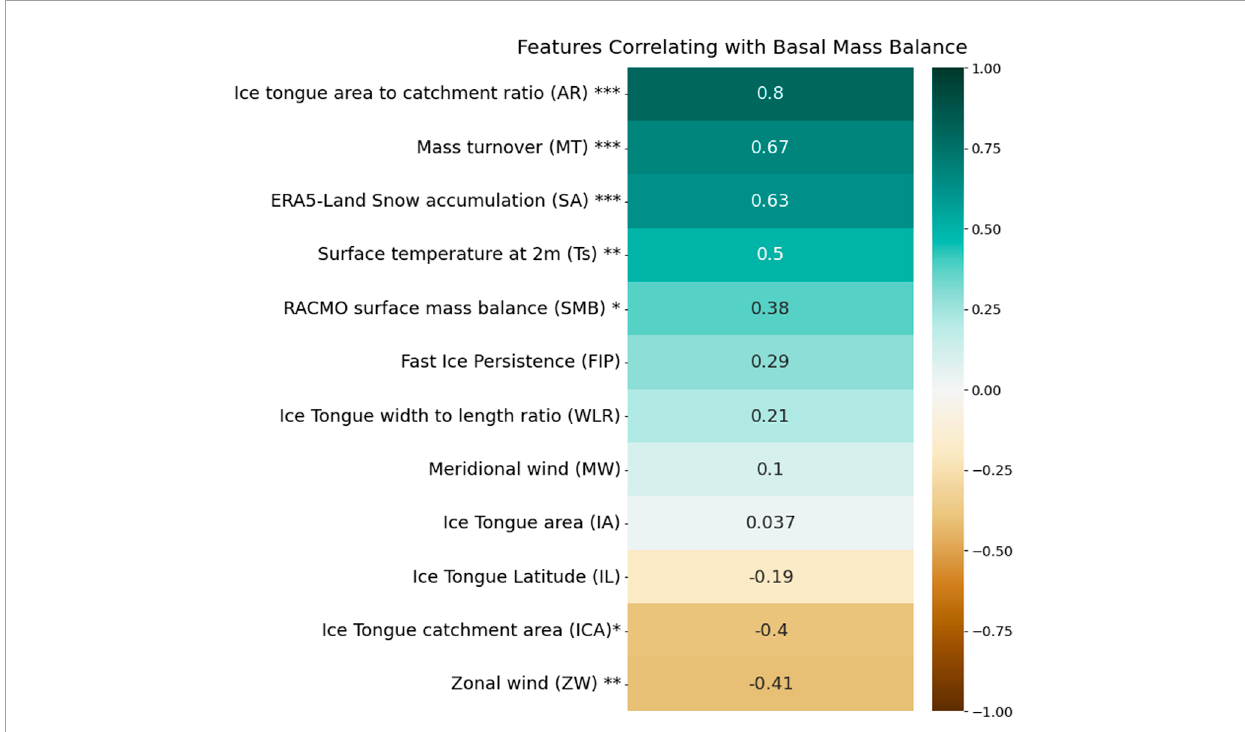
FIGURE 7 Correlation coefficients of different environmental and geomorphological variables with ice tongues basal mass balance. The variables are snow accumulation (SA), surface temperature (Ts), ice tongue mass turnover (MT), ice tongue to catchment area ratio (AR), surface mass balance (SMB), fast ice persistence (FIP), ice tongue width to length ratio (WLR), meridional wind (MW), ice tongue latitude (IL), ice tongue area (IA), ice tongue basin area (ICA), and zonal wind (ZW). The colour code indicates the correlation values. The significance level of the correlation is given by: (***) 95%, (**) 85%, (*) 75%. Correlation values are annotated in each cell, colour scale indicates a correlation from −1 to